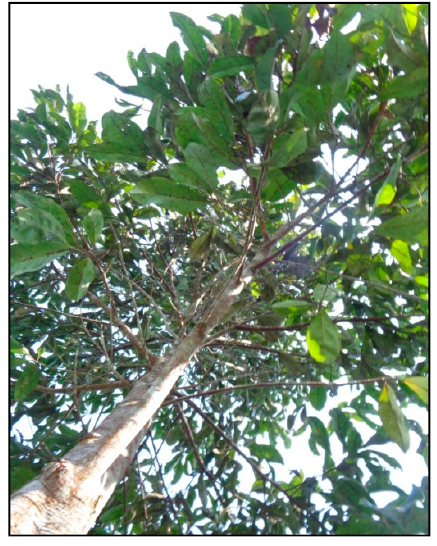
Figure A6. Collecting the wood discs at 0%, 50%, and 100% of the height of the trunk for calculate dry mass; and collecting the sawdust to calculate the mass of the tree. Forests 2017 , 8 , 327 26 of 29